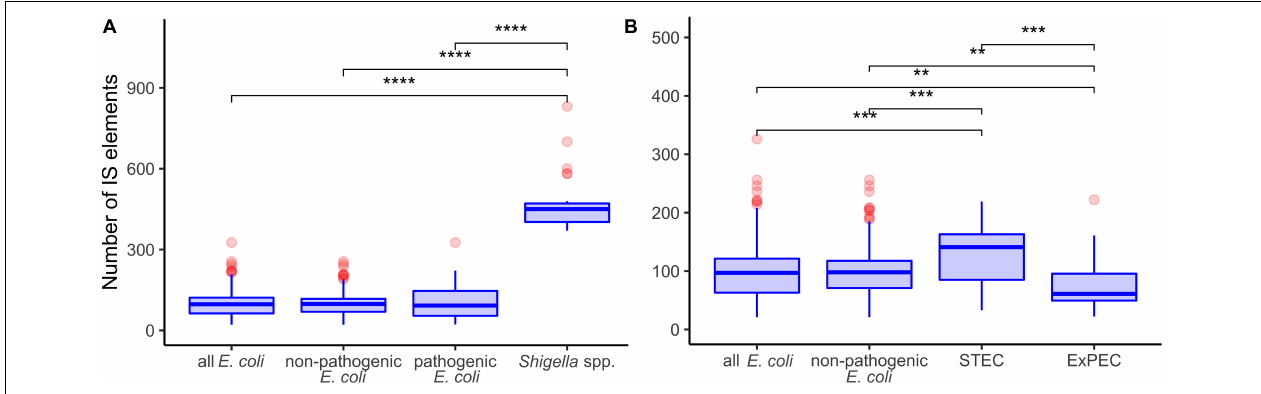
FIGURE 2 | Comparison of insertion sequence (IS) numbers in panel (A) Shigella spp., non-pathogenic E. coli , other pathogenic E. coli , and all E. coli (excluding Shigella spp.); (B) two most abundant pathovars – ExPEC and STEC, non-pathogenic E. coli , and all E. coli (excluding Shigella spp.). The Wilcoxon–Mann–Whitney